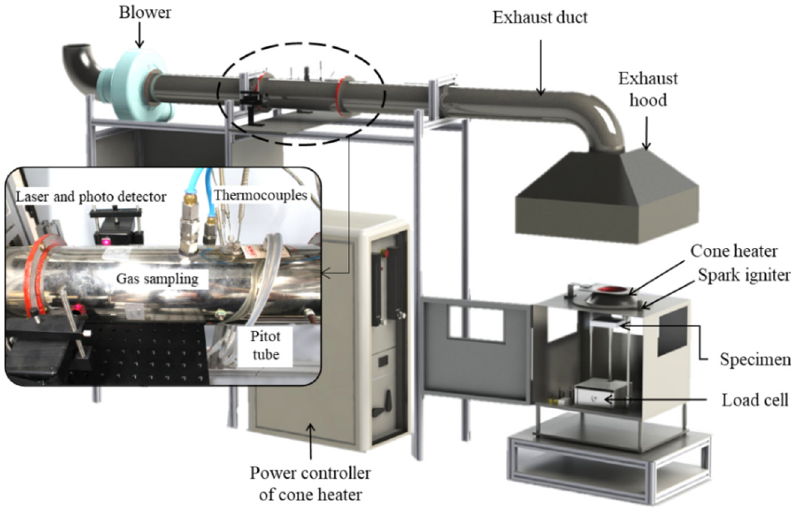
Figure 1. Schematic of a cone calorimeter and photograph of test section.